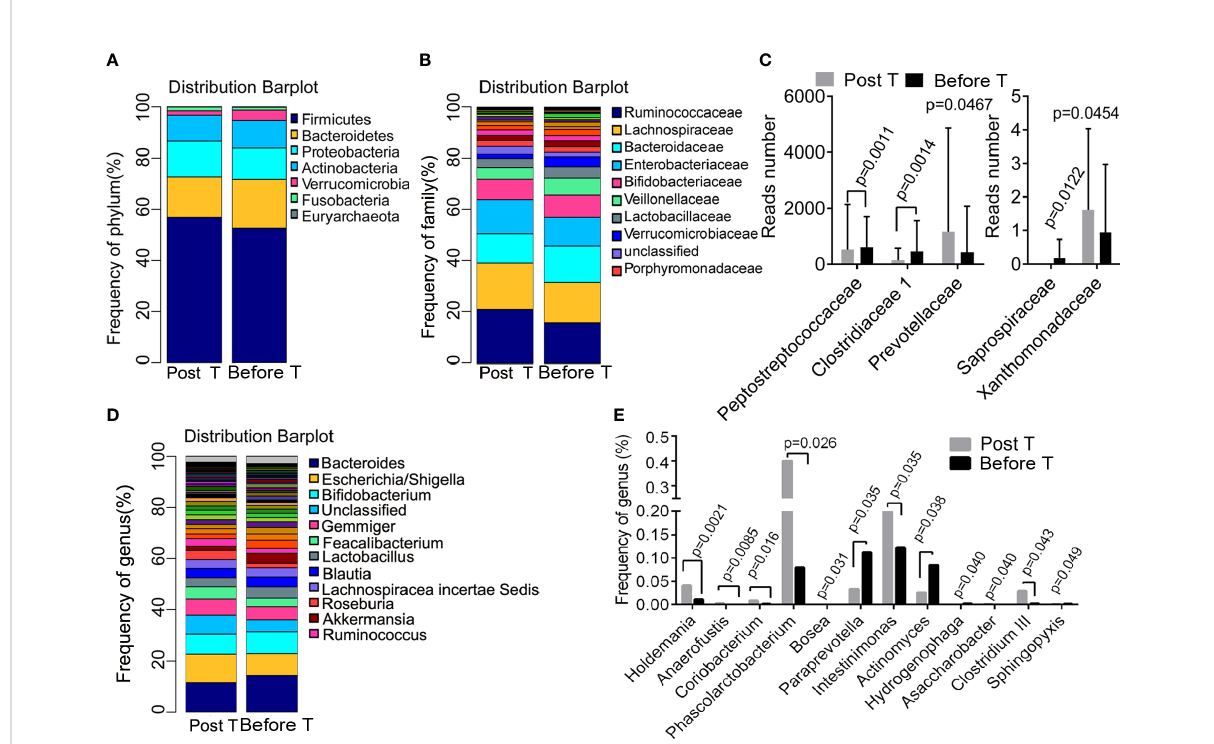
FIGURE 3 Metformin-induced differences in bacteria composition. (A) the dominant phyla before and after treatment; (B) the dominant family before and after treatment; (C) the different family before and after treatment; (D) the dominant genera before and after treatment; (E) the different genera before and after treatment. T,